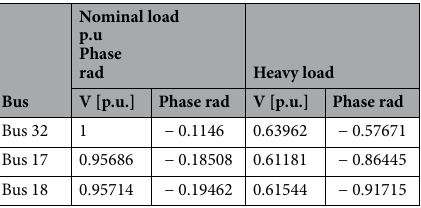
Nominal load p.u Phase